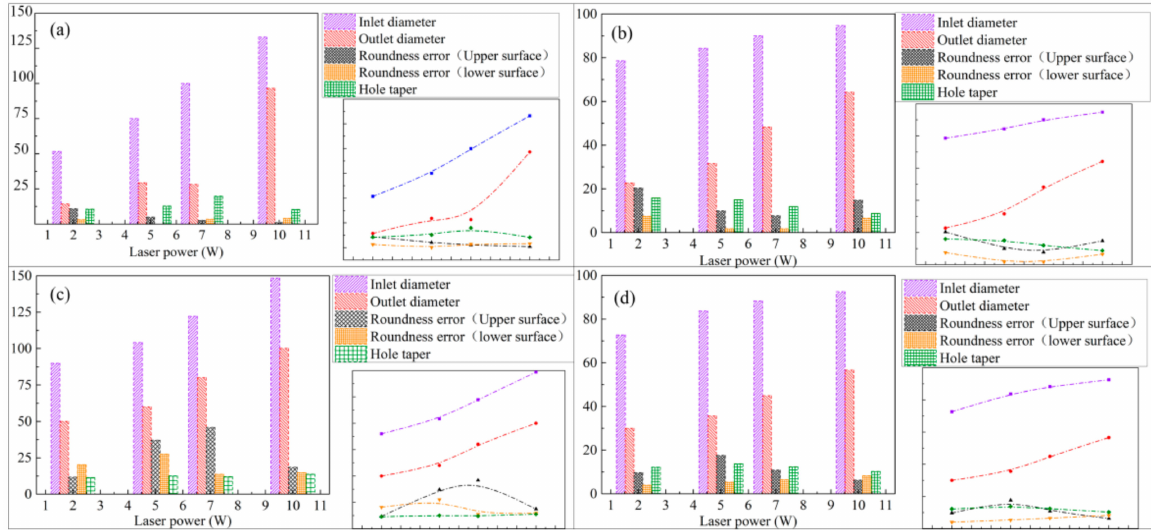
Figure 12. Hole appearance characteristics after fixed-position processing different metal materials: ( a ) aluminum alloy, ( b ) titanium alloy, ( c ) copper, ( d ) stainless